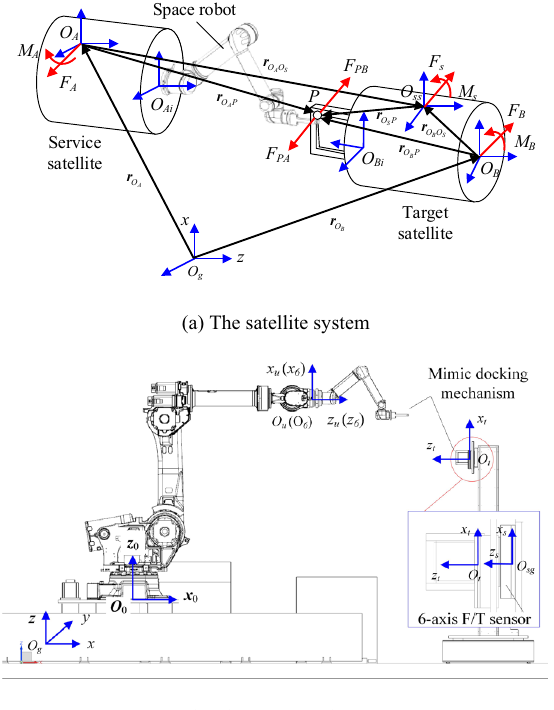
Figure 2 Coordinate systems